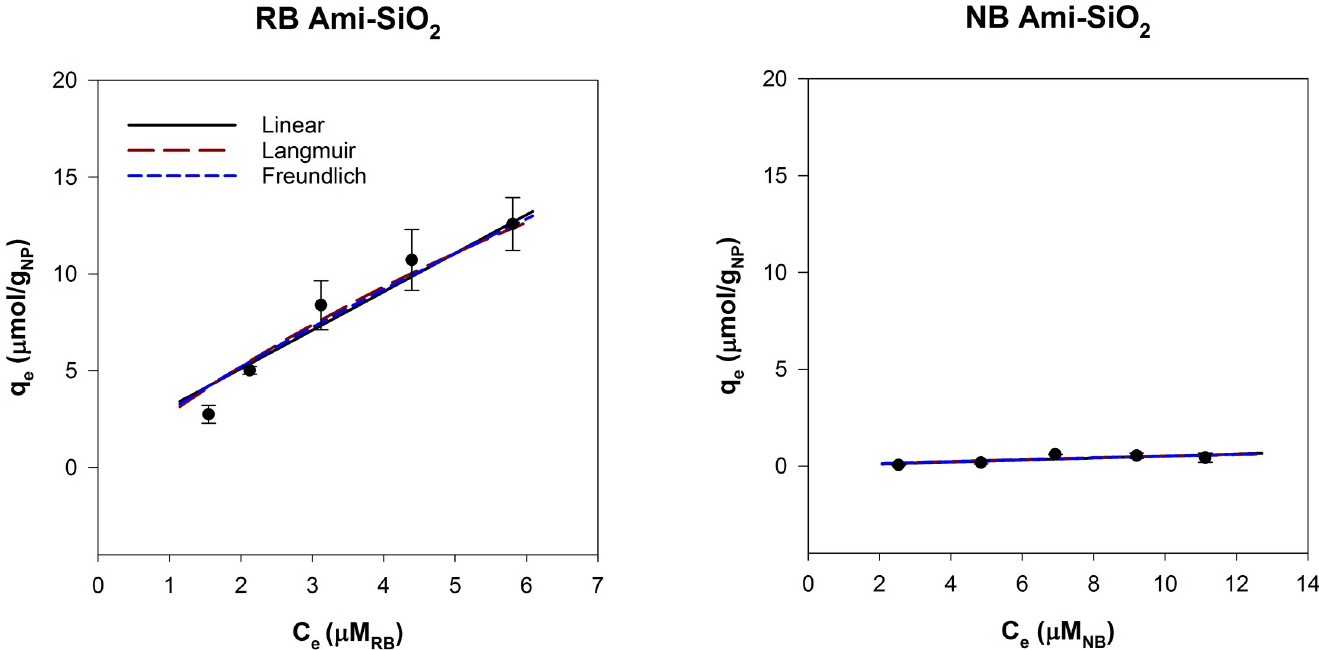
Fig 6. Adsorption isotherms for 500 mg/L Ami-SiO 2 NPs with Rose Bengal and Nile Blue, modeled with linear, Langmuir and Freundlich adsorption models.